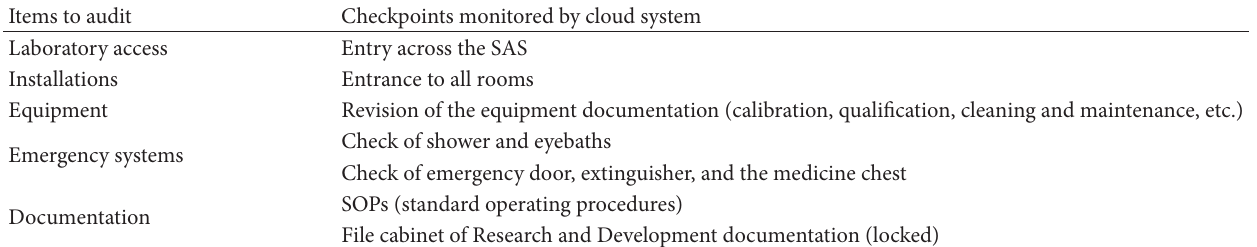
Table 1: Relation about key aspects in the training process and checkpoints that we need to know using the cloud-based analysis